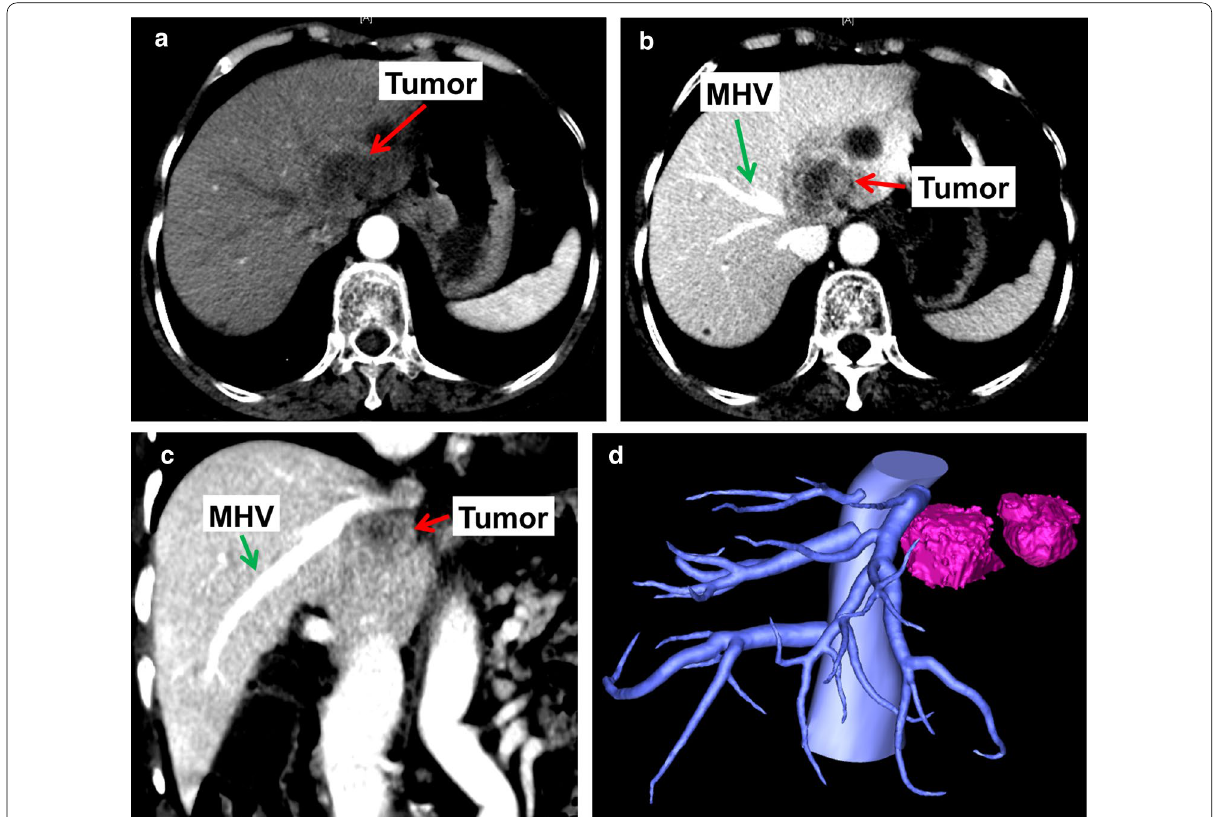
Fig. 8 The intrahepatic cholangiocarcinoma was located in root of hepatic vein, which infiltrated the middle hepatic vein and the left hepatic vein. a Shows the location of tumor in artery phase. b Shows the relationship between tumor and MHV in transverse section. c Shows the relationships between tumor and MHV in coronal section. d The three-dimensional reconstruction of tumor and hepatic vein. MHV middle hepatic vein.